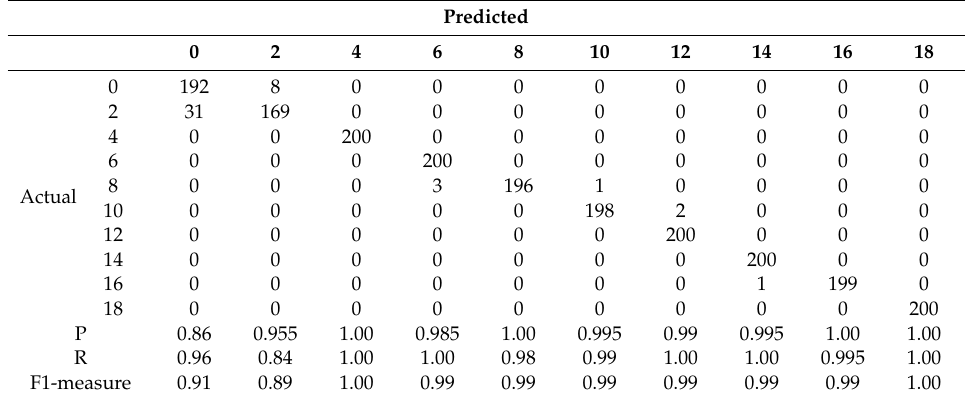
Table 2. The confusion matrix, precision, and recall of classifying 10 noise levels by the proposed network.